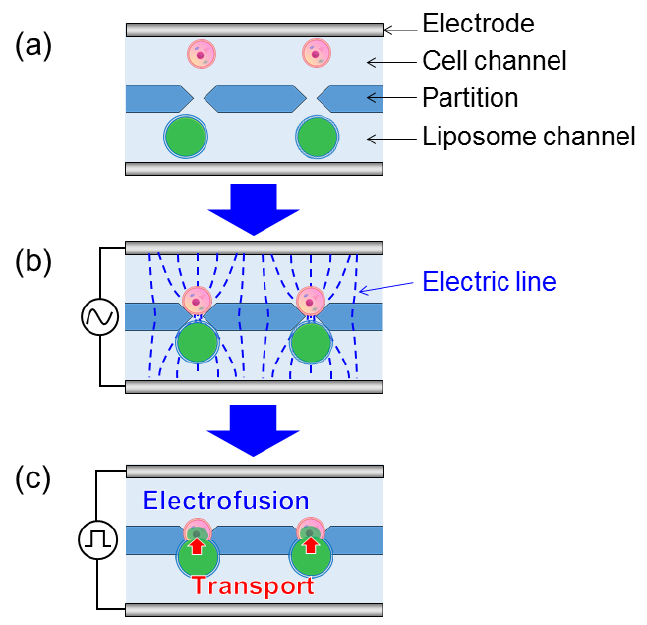
Figure 1. Principle of the one-to-one electrofusion method between a cell and a giant liposome. ( a ) Cells and giant liposomes were separately introduced into the partitioned microchannel. ( b ) An alternating current (AC) voltage was applied between the electrodes. Cells and giant liposomes approached gaps between the partitions due to positive dielectrophoretic force and they adhered to each other by Coulomb force. ( c ) A direct current (DC) voltage was applied. Electrofusion and transport of substance occurred between the cell and the giant liposome.